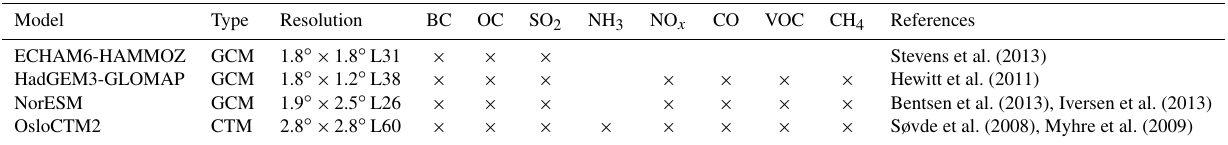
Table 1. The models and species included. Models are either general circulation models (GCM) or chemistry transport models (CTM). The resolution column shows the horizontal resolution and the number of vertical layers. Model Type Resolution BC OC SO 2